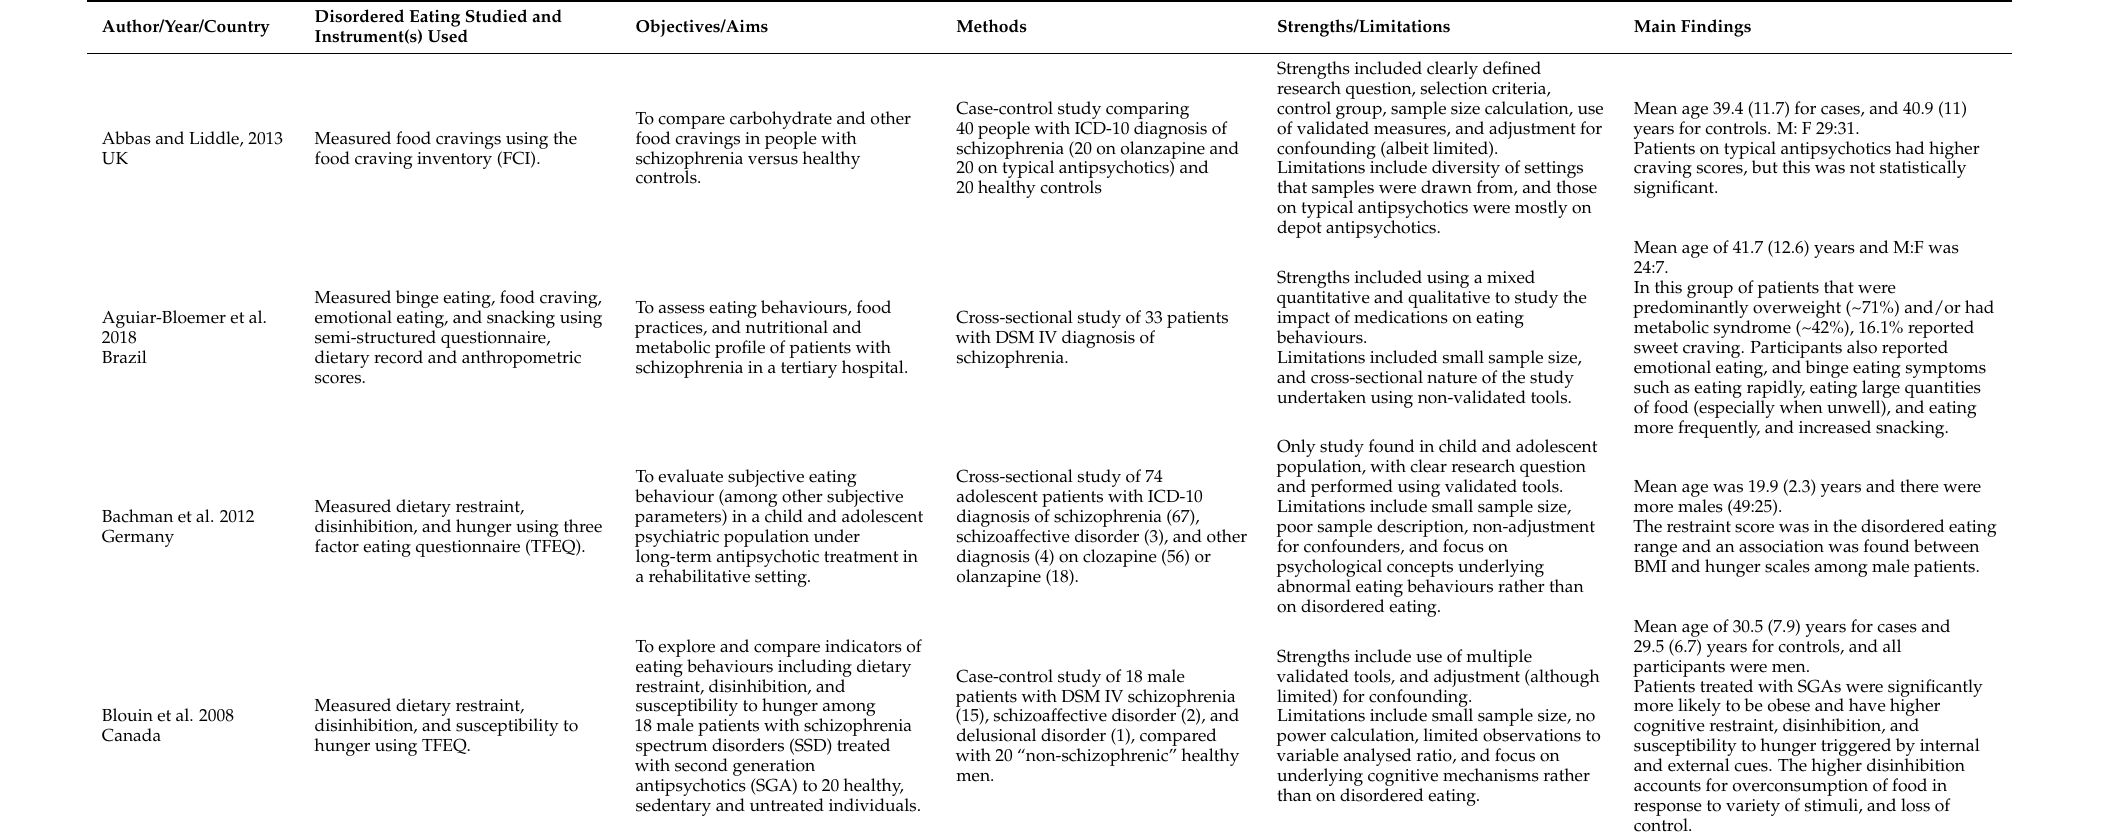
Table 3. Summary of included